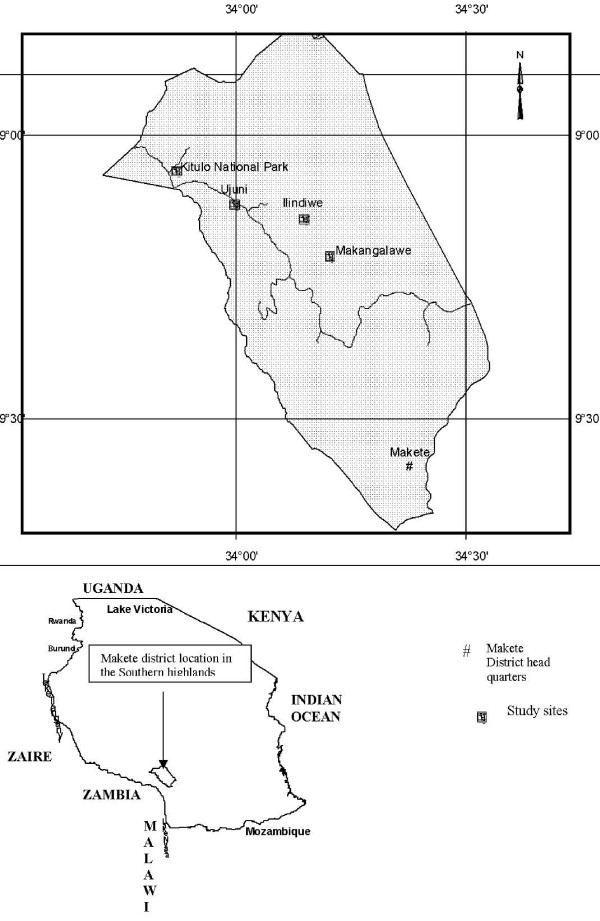
Map of study area.